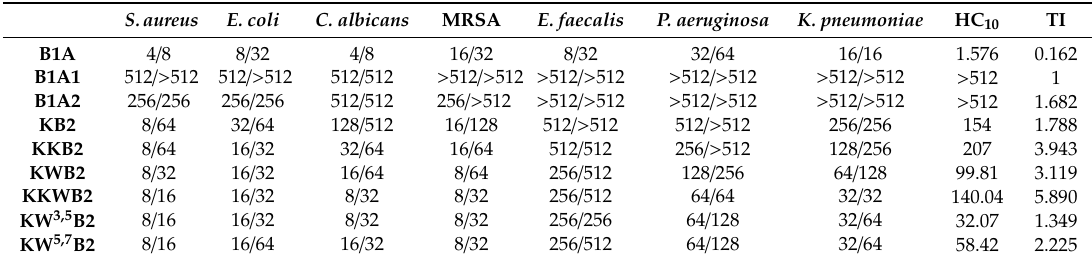
Figure 3. ( a ) The haemolytic activity of novel peptides (B1A) and its analogues on horse erythrocytes. Phosphate buffered saline (PBS) and 1% TritonX-100 were used as the negative control (NC) and positive control (PC), respectively; ( b ) relationship of peptide’s (KKB2, KB2, KKWB2, KWB2, KW 5,7 B2, and KW 3,5 B2) hydrophobicity and 10% haemolytic complement (HC 10 ) on horse erythrocytes. Data represent means ± SD of five replicates. Table 3. Minimum inhibitory concentration (MICs), minimum bactericidal concentration (MBCs), HC 10, and therapeutic indices (TIs) of B1A and its